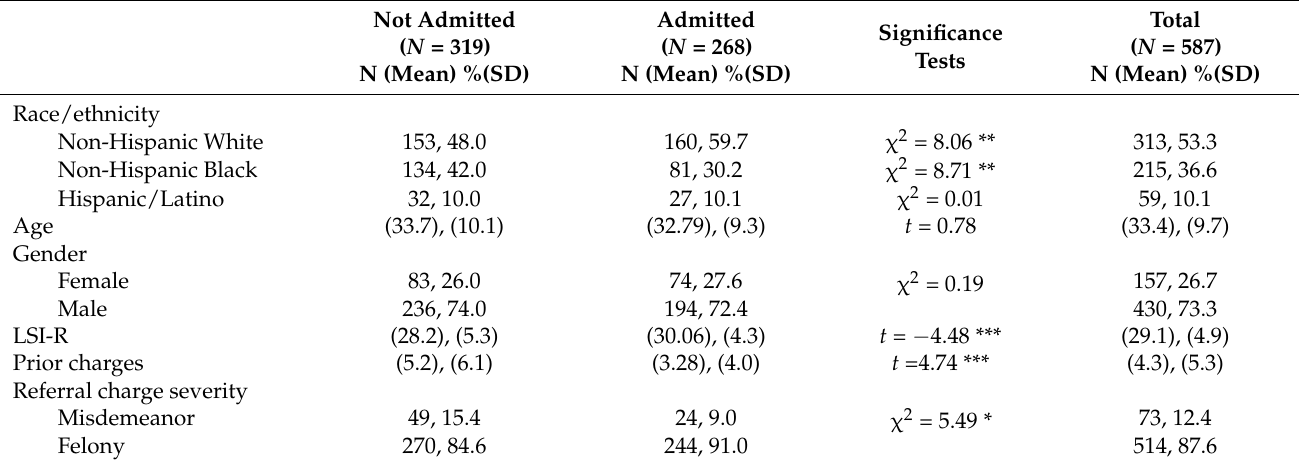
Table 1. Descriptive Statistics for the Likelihood of Admission ( N = 587).